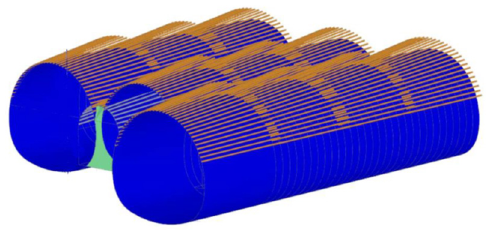
Figure 7. A cross section of a tunnel with rock bolts and pipe roofings: ( a ) the pilot tunnel and ( b ) the eastbound tunnel. In the tunnel designer of the PLAXIS 3D program, the cross section of the middle double pilot tunnel was built first, and rock bolts and pipe roofings were added in the material settings. Then, the excavation trajectory was simulated. The last step was the ex- cavation process. In addition, for the construction of the three main tunnels, additional dividing lines for stepped excavation were added to the part of the drawn line segment, and the rest were consistent with the pilot tunnel. After the settings were completed, the entire tunnel prototype could be generated, as shown in Figure 8. The next step was to divide the model’s soil and structures to form a grid, as shown in Figure 9. There are five types of mesh density, such as coarse, medium, and fine. Its roughness can be adjusted to differentiate the rock mass and structure, and it can be adjusted freely according to the required precision. To improve the precision of the structure, mesh refinement can be per- formed. Figure 8. The prototype of the guide pit and the triple adjacent tunnels. Figure 9. Model grids for the triple adjacent tunnels.